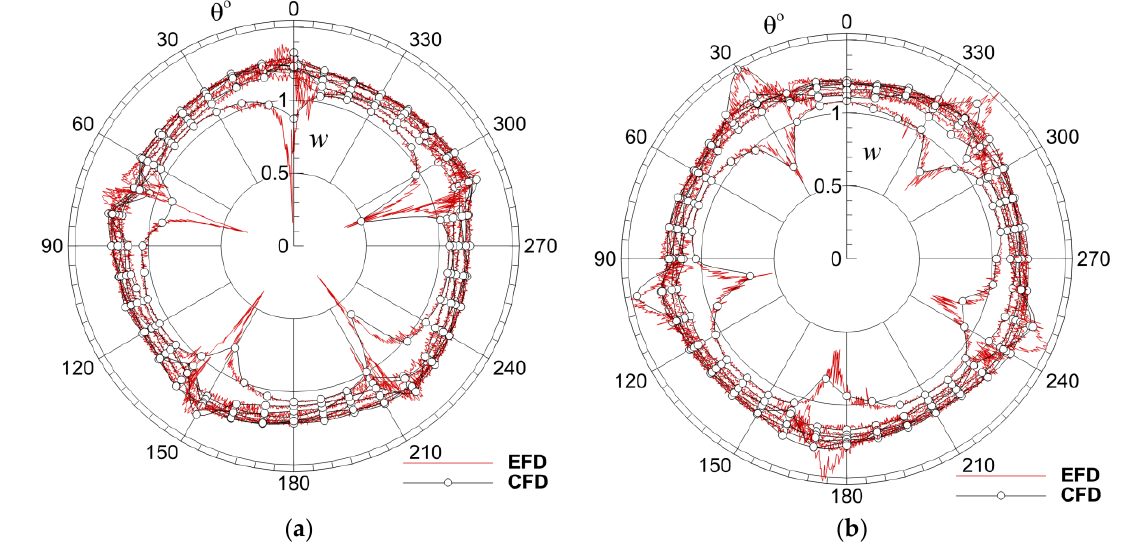
Figure 11. Comparisons between the experimental [44] and computed wake. ( a ): x / D = 0.1; ( b ): x / D = 0.2.